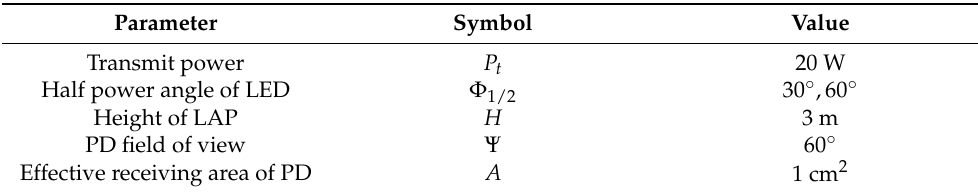
Table 1. Simulation